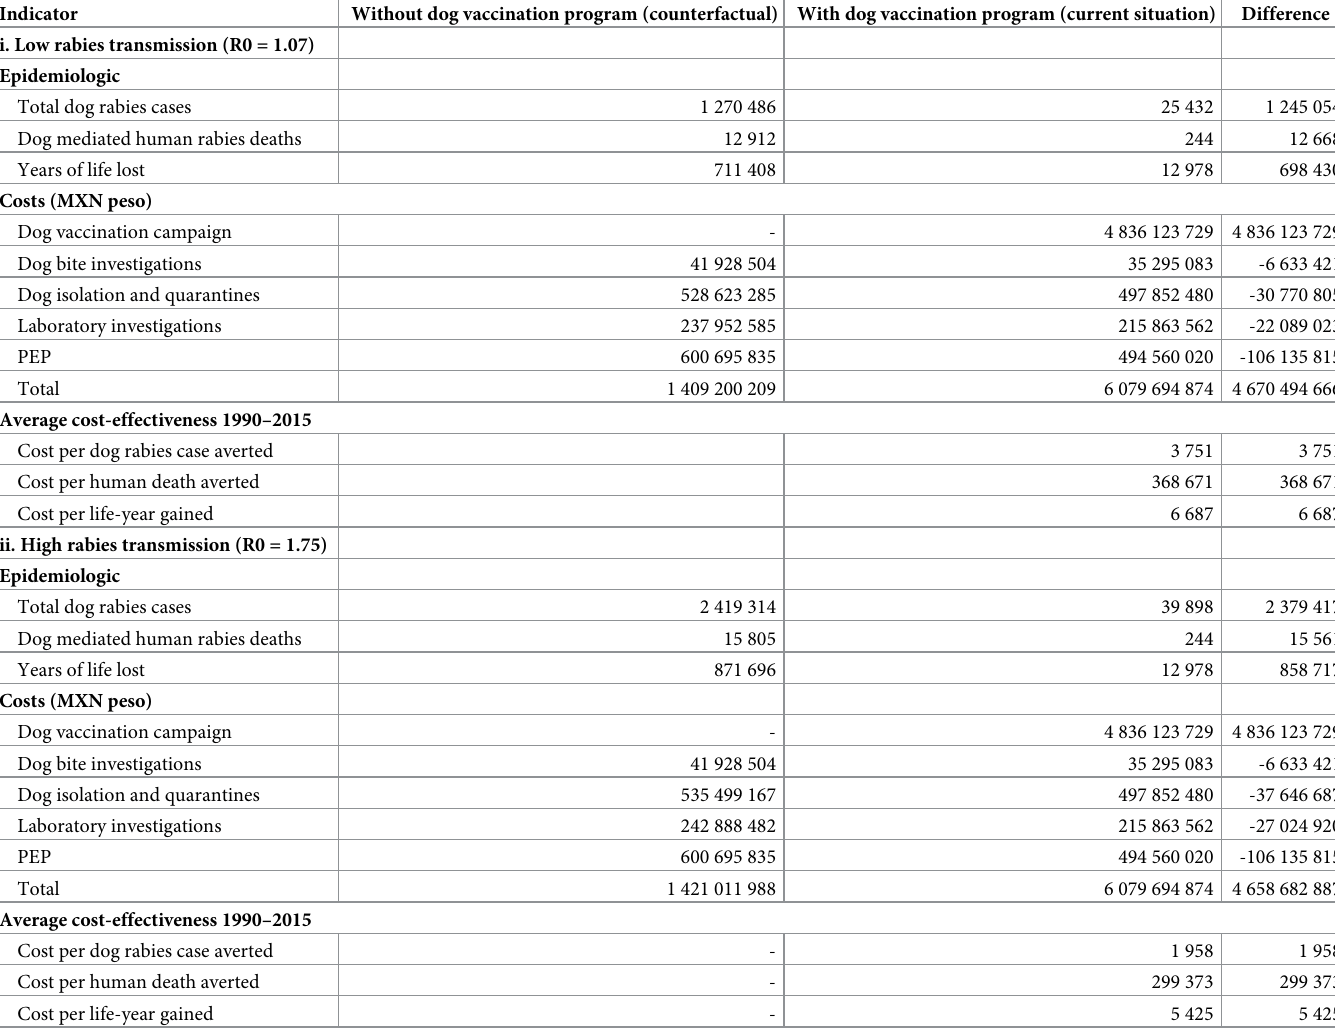
Table 4. Sensitivity analysis. Main results for the average cost-effectiveness evaluation of the national program of rabies control in Mexico, 1990–2015 (MXN 2015), in two hypothetical scenarios of (i) low dog-to-dog rabies transmission (R 0 = 1.07), and (ii) high dog-to-dog rabies transmission (R 0 = 1.75) a .